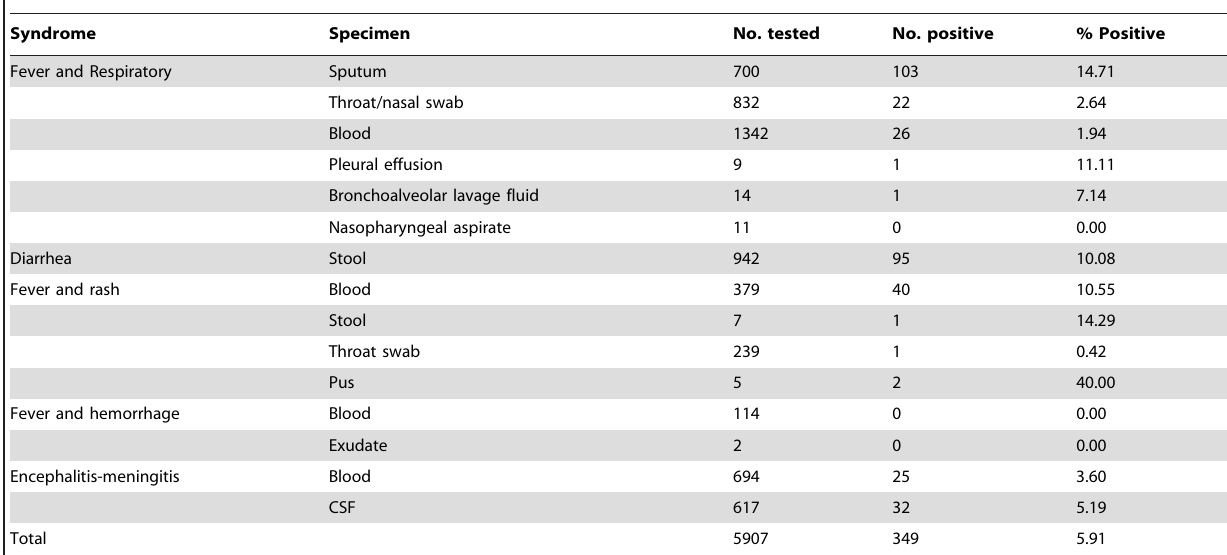
Table 2. Positive Cultures by specimen type for five core